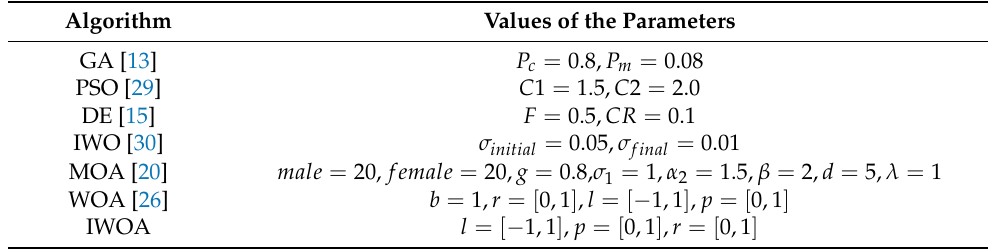
Table 2. Parameter setups of different